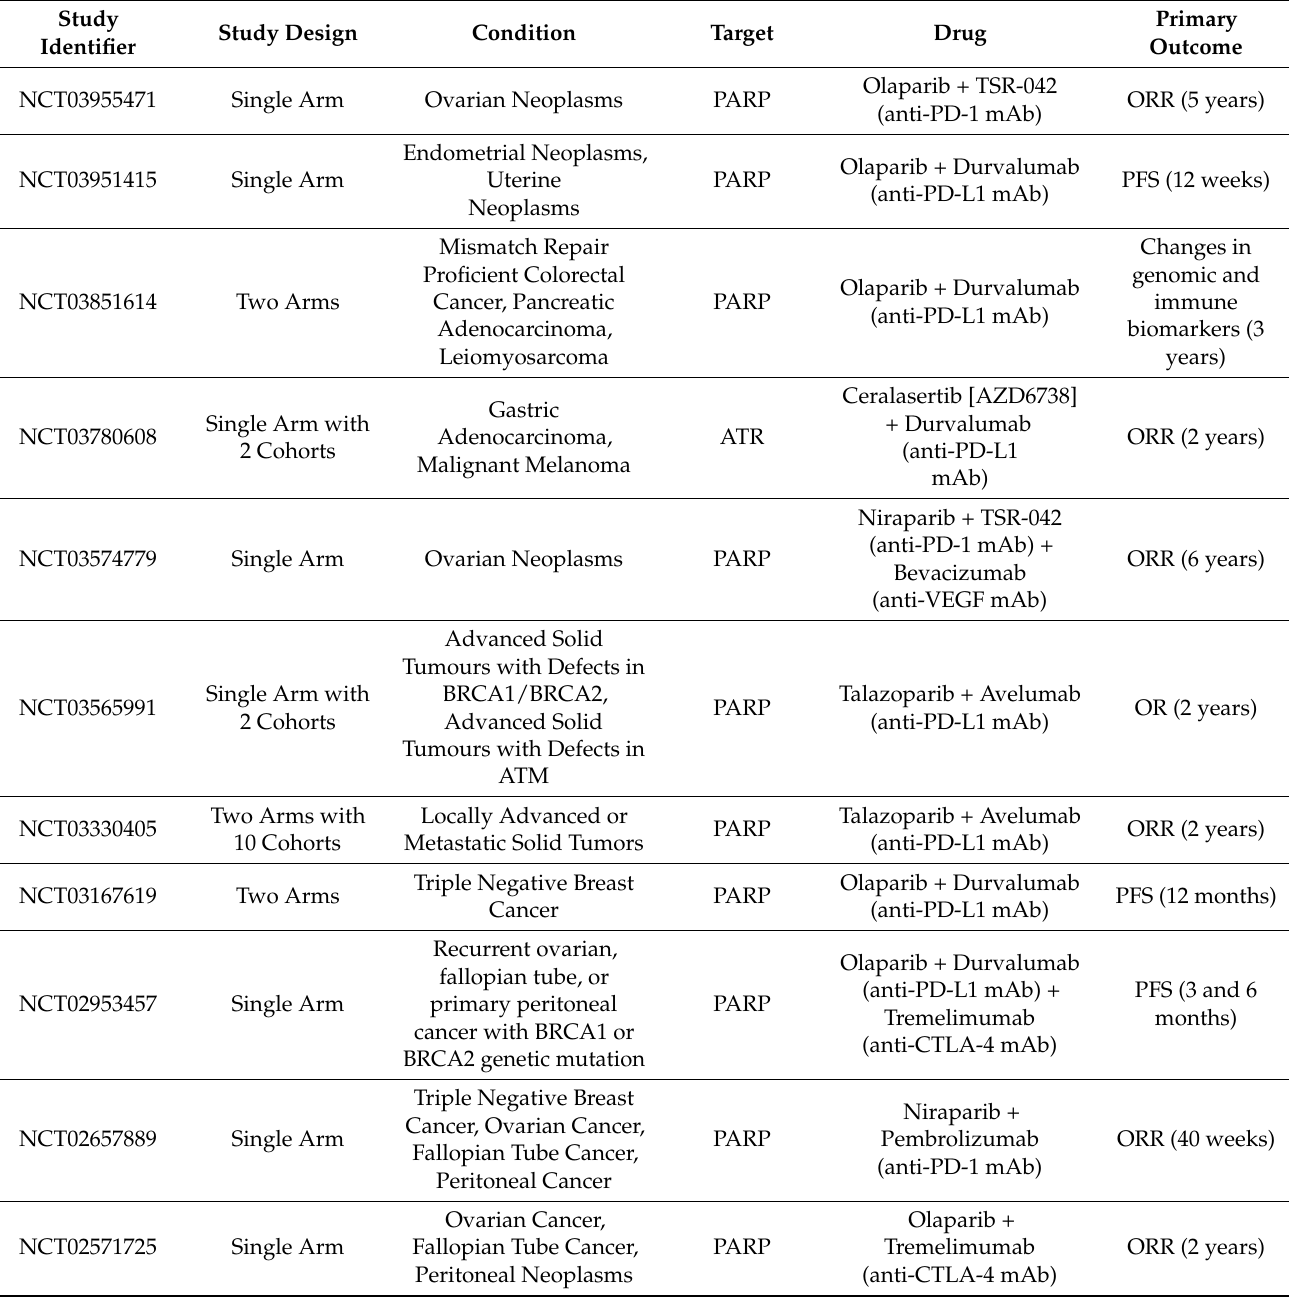
Table 1. Phase II clinical trials combining agents targeting DNA damage response with immune checkpoint inhibitors (ClinicalTrials.gov; accessed on 1 October